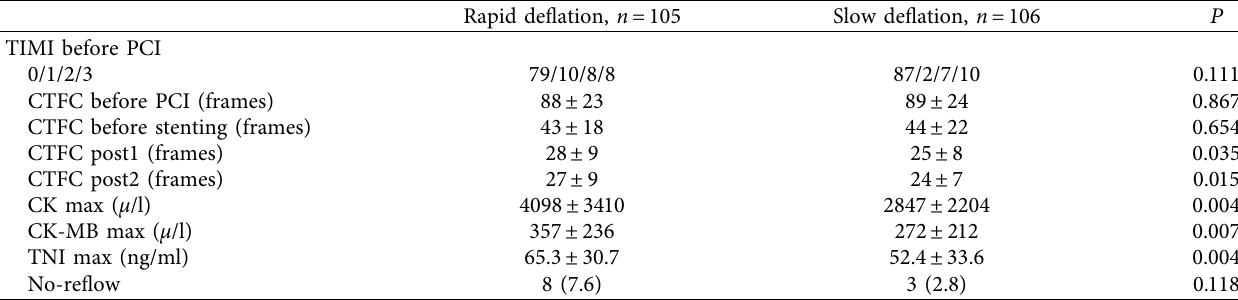
Table 4: Results of coronary flow.